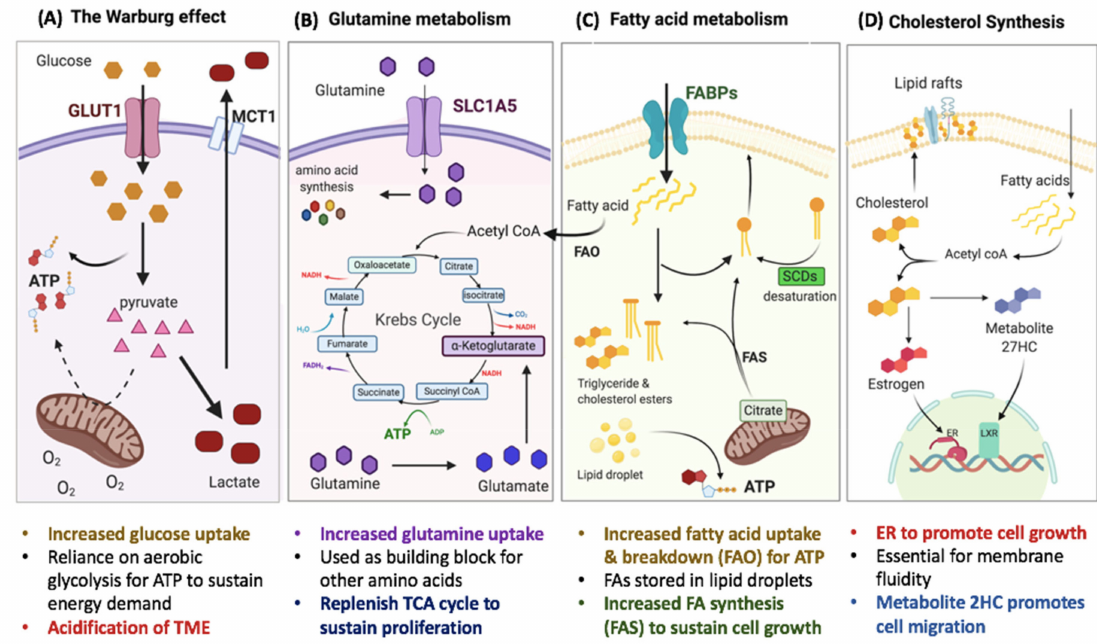
Figure 1. Metabolic adaptation in breast cancer cells and CSCs. ( A ) Cancer cells tend to adopt the Warburg e ff ect or aerobic glycolysis, exhibiting a reliance on glycolysis instead of OXPHOS for ATP generation even with adequate supply of oxygen. The resulting pyruvate is converted into lactate and released outside the cell where it acidifies the tumor microenvironment (TME), creating an immunosuppressive environment. ( B ) Cancer cells also shift their dependence to glutamine for anabolic processes for cell growth (such as nucleotide and other amino acid synthesis) and to replenish the Krebs (tricarboxylic acid (TCA)) cycle. Glutamine is also important in the synthesis of glutathione, which is instrumental in chemo-resistance. ( C ) Both fatty acid oxidation (FAO) and fatty acid synthesis (FAS) are upregulated in breast cancer to supplement glycolysis for energy and to provide membrane materials for rapid cell proliferation and growth. ( D ) Cancer cells are also dependent on cholesterol synthesis for their membrane composition and signaling to promote growth and